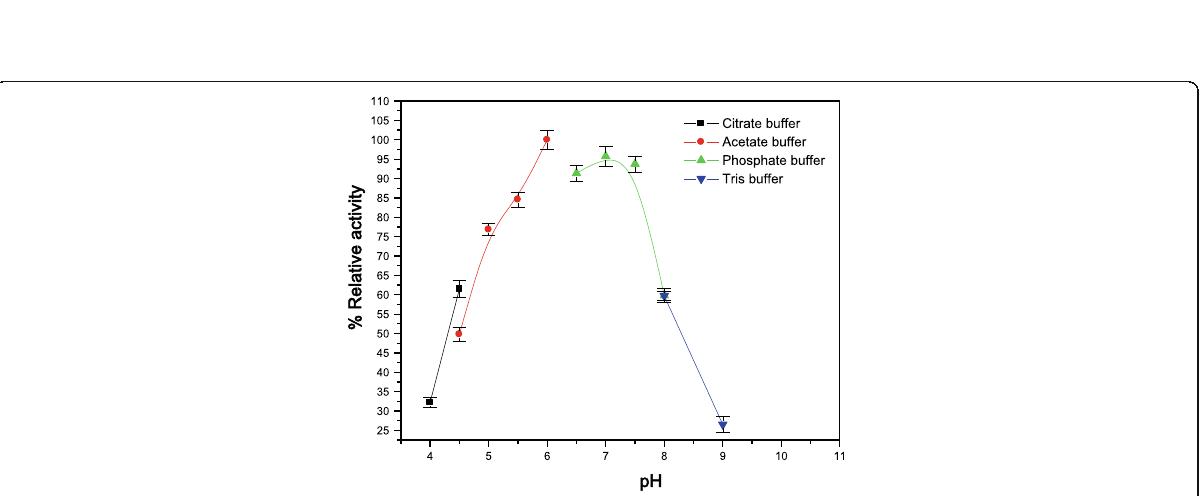
Fig. 6 pH optimum of ginger GPII. The reaction mixture contained in 1.0 ml: 8 mM H 2 O 2 , 40 mM guaiacol, a suitable amount of enzyme, and 20 mM sodium citrate buffer (pH 4.0 – 4.5), sodium acetate buffer (pH 4.5 – 6.0), sodium phosphate buffer (pH 6.5 – 8.0), and Tris – HCl buffer (pH 8.0 – 9.0). The points are presented as mean ± S.E. ( n =